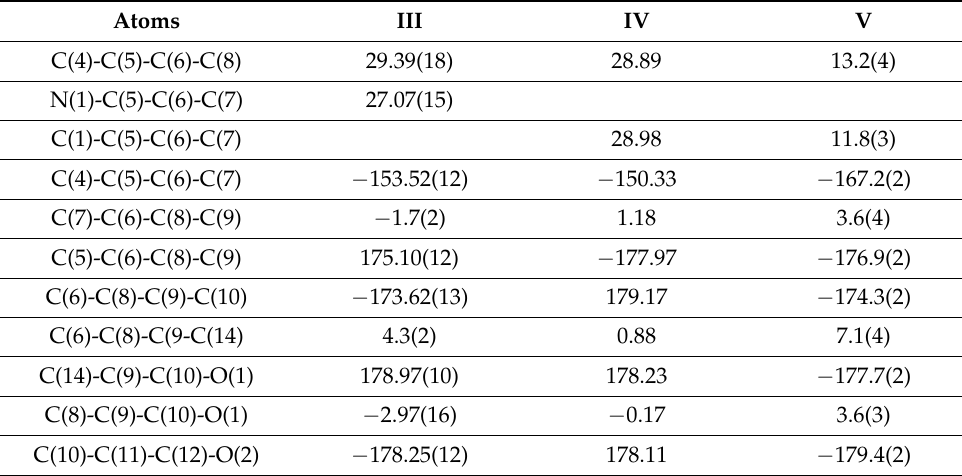
Table 6. Selected torsion angles ( ◦ ) for the molecular structures of III – V .